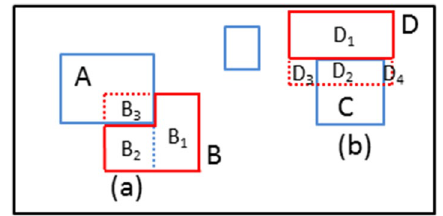
Fig. 7 The instance of intersection and division after new inserting MBH in 2D space. A Division when nodes intersect on one dimension, B Division when nodes intersect on multi dimensions. Note: The blue rectangle indicates an existing cluster cell, and the red rectangle indicates a new cluster